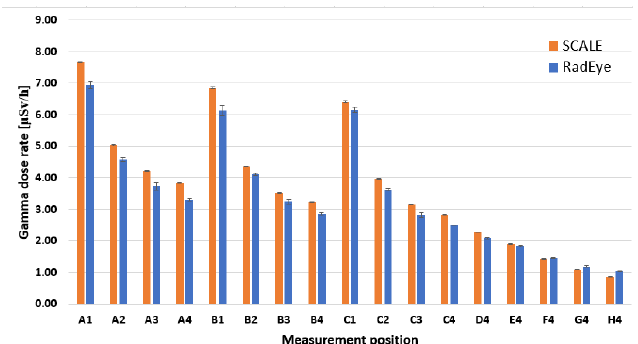
Fig. 15. Comparison of photon effective dose (SCALE) and measured